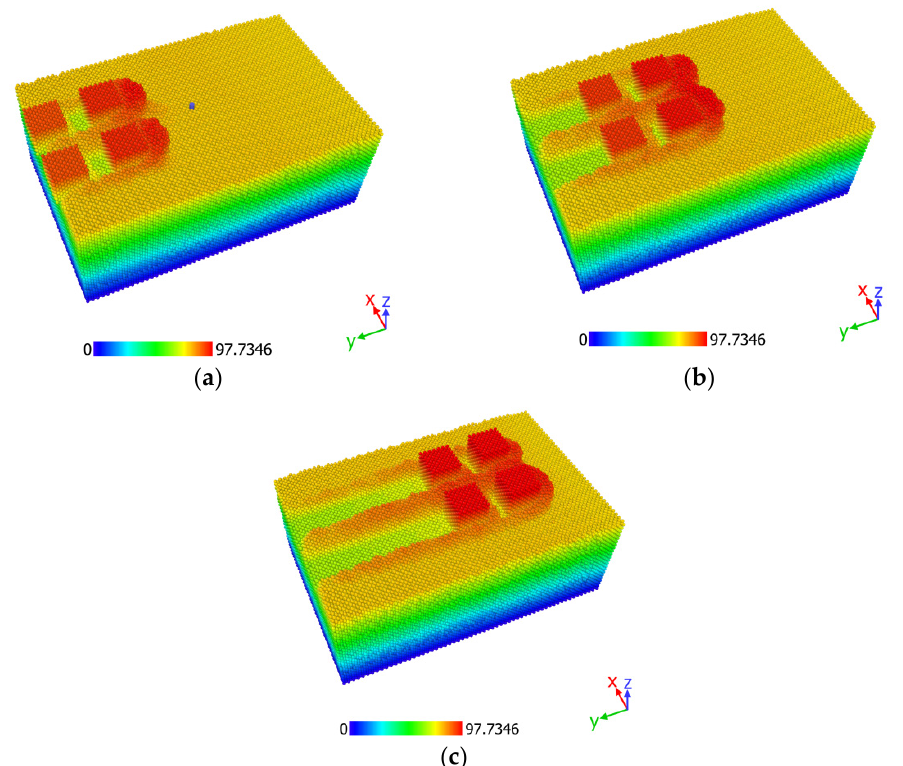
Figure 2. Three snapshots from an indicative nano-grinding simulation (copper, initial temperature: 293 K) at ( a ) 30 ps, ( b ) 50 ps, and ( c ) 80 ps.